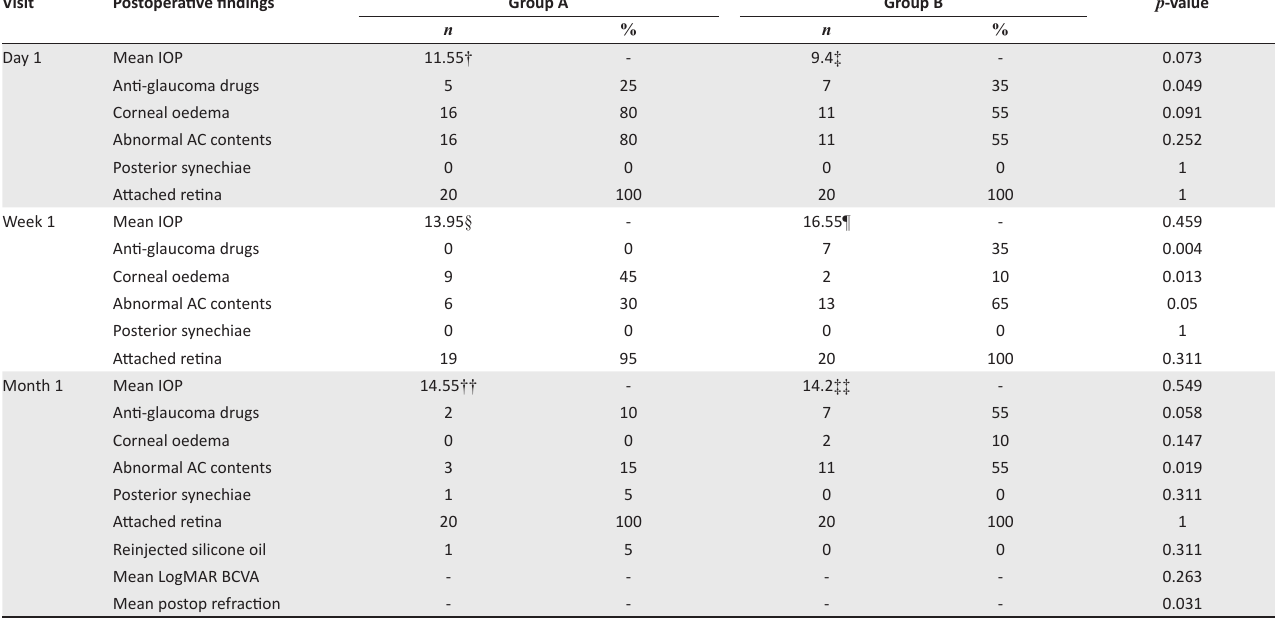
TABLE 6: Second procedure postoperative